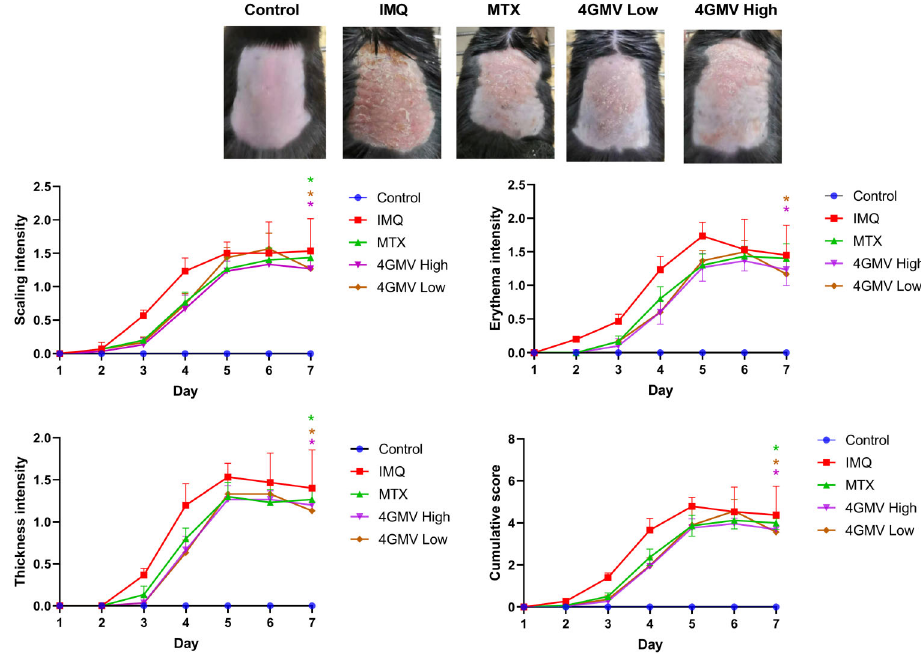
Figure 2. A mouse model of psoriasis was induced by topical application of imiquimod (IMQ). Top : Psoriasis-like skin lesions were observed after 7 days in the IMQ-treated group. Animals administered methotrexate (MTX) (1 mg/kg), 4GMV low (6 mg/kg), and 4GMV high (12 mg/kg) showed ameliorated symptoms. Bottom : Scaling, erythema, and thickness of the back skin was scored on a scale from 0 to 4. The cumulative Psoriasis Area and Severity Index (PASI) is also depicted. Data are reported as means ± SD (n=6 per group). *P o 0.05 compared with the IMQ model group (ANOVA).